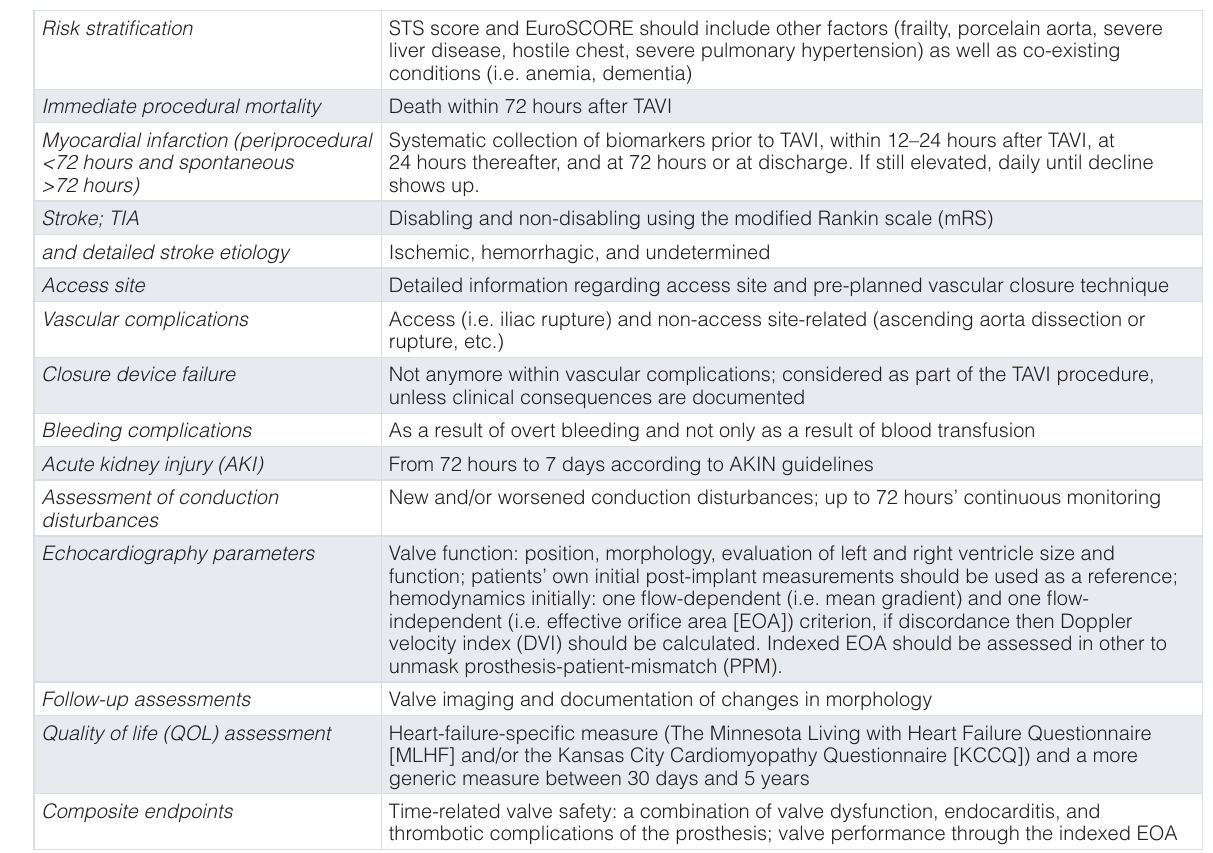
Table 2. Valve Academic Research Consortium (VARC)-2